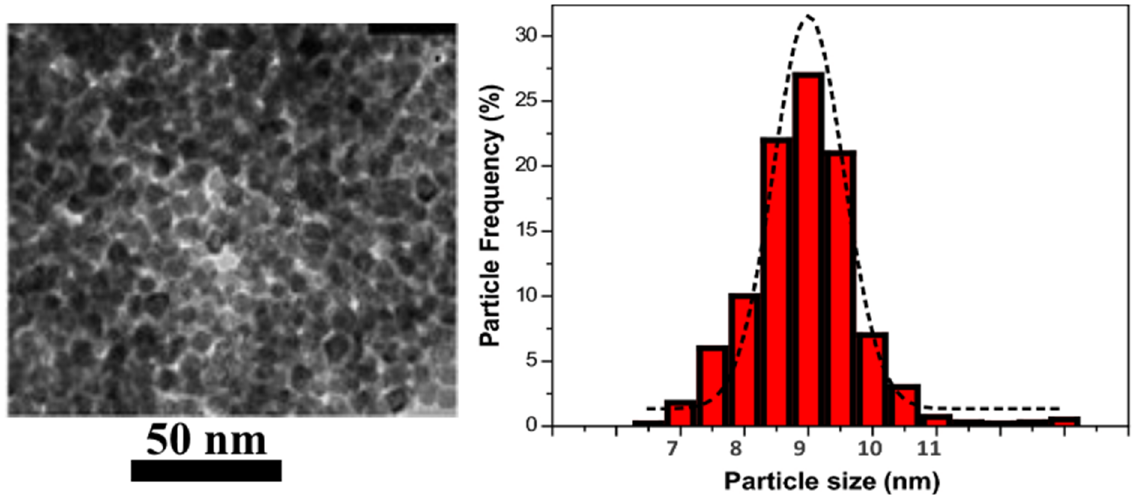
Figure 12. TEM image and size distribution histogram of the activated FA-TiO 2 catalyst.